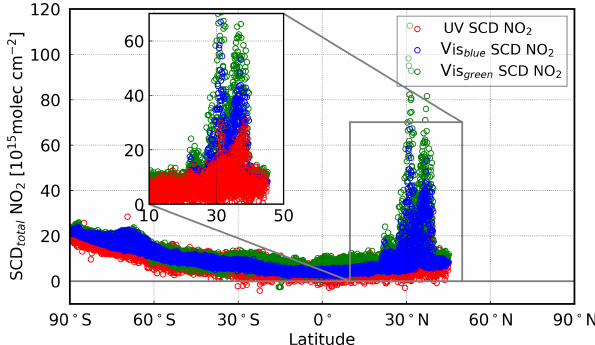
Figure 5. Total NO 2 SCDs of one orbit (above east China on 3 January 2008) for three fitting windows in the UV, blue, and green spectral range. Only data with SZA smaller 70 ◦ are